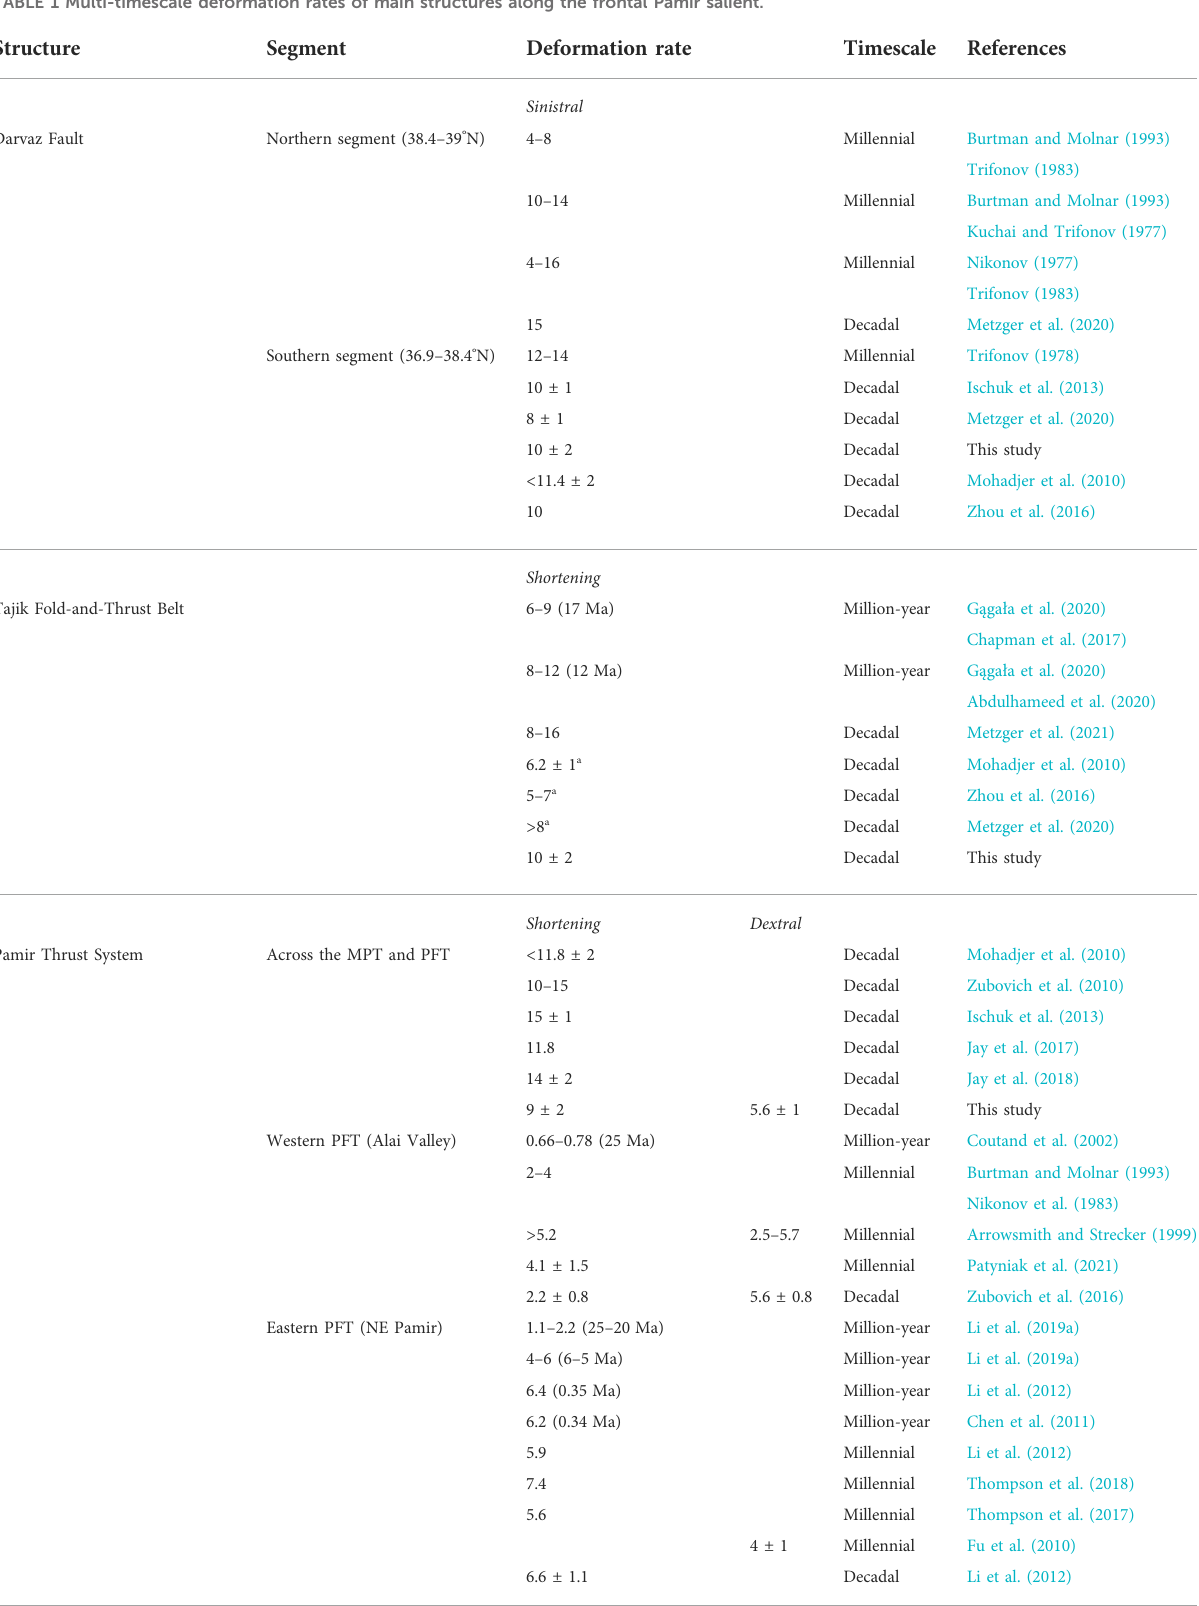
TABLE 1 Multi-timescale deformation rates of main structures along the frontal Pamir